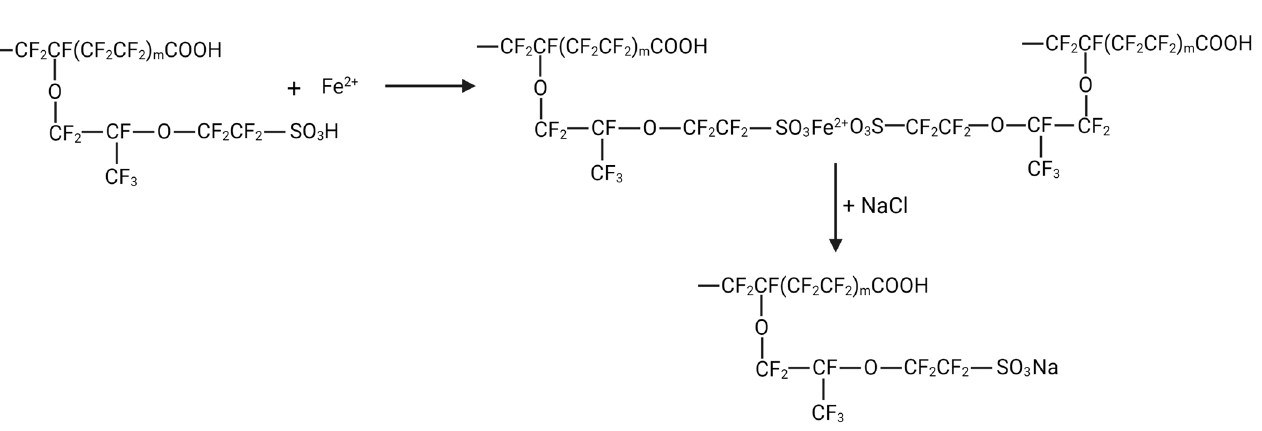
Figure 6. Mechanical properties of the membrane after ex situ degradation test with Fenton’s rea- gent: ( a ) tensile yield strength (MPa) of membranes at di ff erent temperatures; ( b ) Young’s modulus (MPa) of membranes tested at di ff erent temperatures.